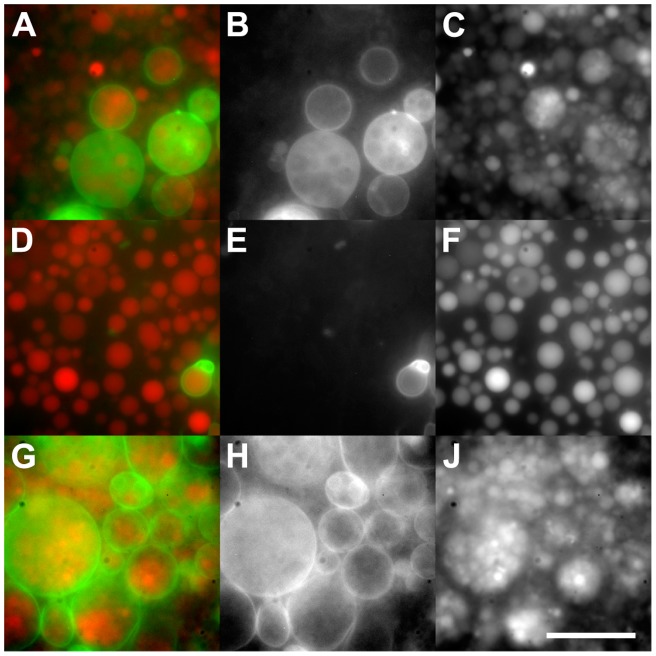
Fluorescence micrographs of intact hierarchical unilamellar vesicles (HUVs) and released giant unilamellar vesicles (GUVs).Intact HUVs and released GUVs before (A–C) and after separation (D–J). A, D, G) Image overlays of the green and red channel micrographs. B, E, H) Separate green channel and C, F, J) separate red channel micrographs. A) The intact HUVs are indicated by the confining membrane fluorescently labeled green and the encapsulated GUVs loaded with a fluorescent cargo (red). In addition, solitary released GUVs not confined by a green labeled membrane are visible. After separation, released GUVs (D) became spatially separated from intact HUVs (G). Scale bar: 25 μm.